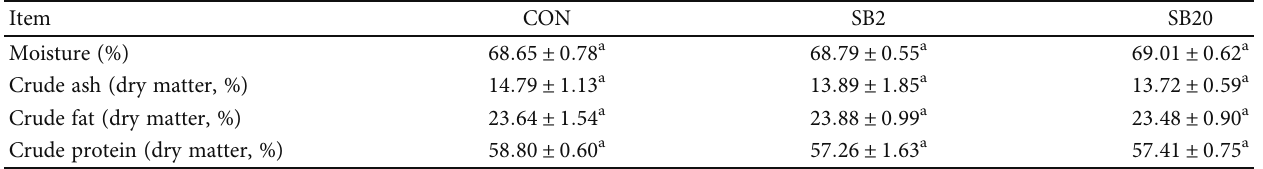
Table 4: E ff ects of two dosages of sodium butyrate on the body composition of largemouth bass, Micropterus